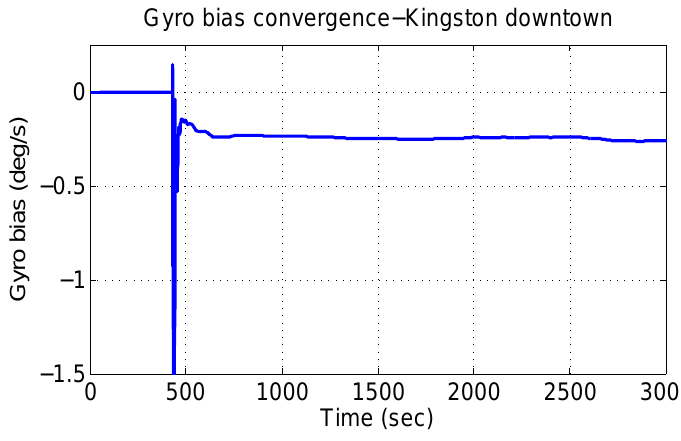
Figure 13. Gyroscope bias estimation convergence in the Kingston downtown trajectory.